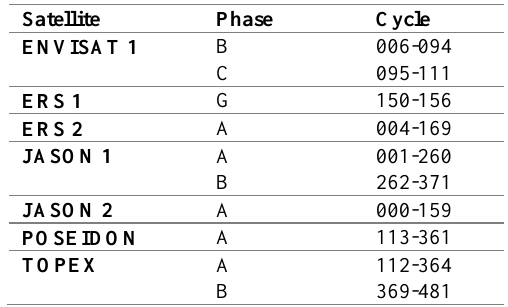
Table 3. Single-mission satellite altimeter selected data from 1